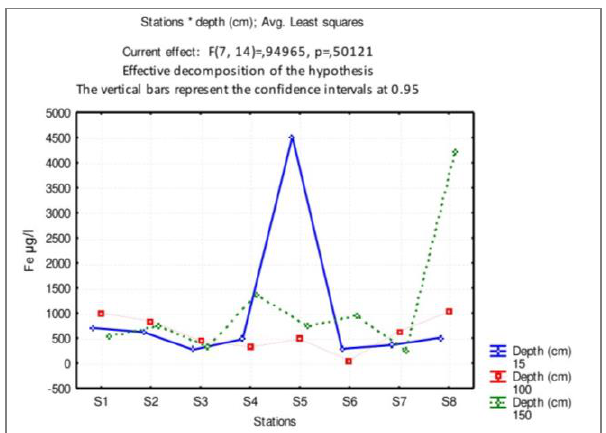
Figure 8. Spatial variation of Fe in μg/l in the Reghaia lake. Zinc levels range from 0.01 to 0.2mg/L of the surface to the depth of the lake and for lake entry the content is 0.1 mg/L. While for the dam is the concentration of this element is the order 0.04 mg / L ( Figure 9 ).